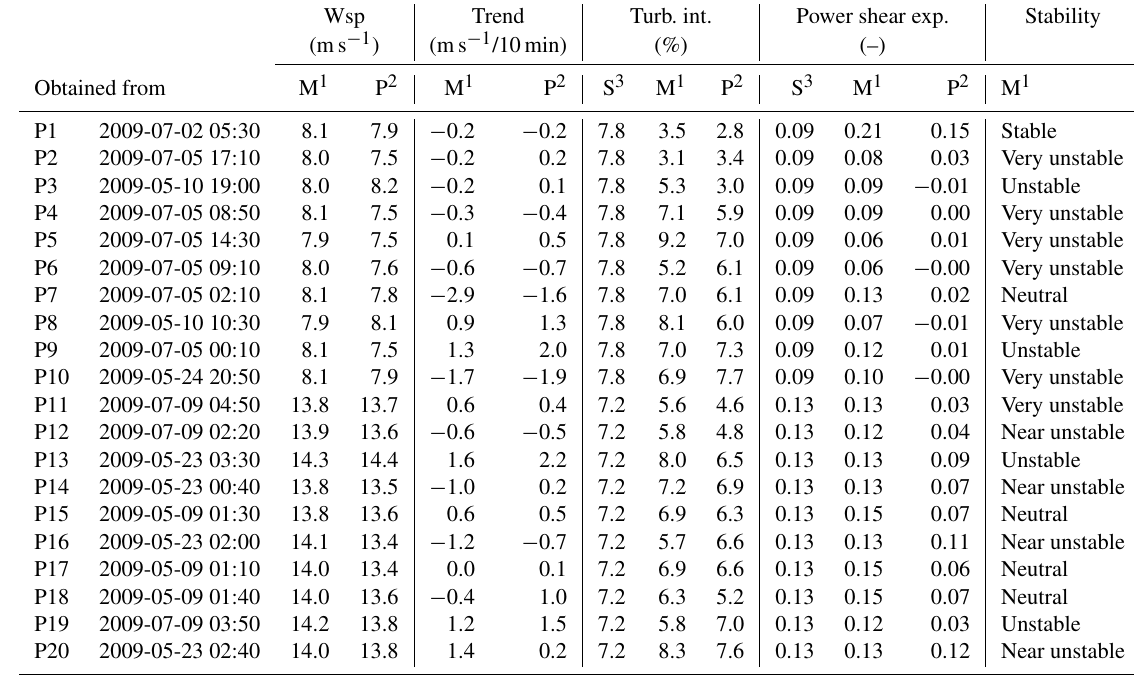
Table 2. Inflow characteristics of P1–P20 showing the wind speed (Wsp), wind speed trend (Trend), turbulence intensity (Turb. int.) and power shear exponent (Power shear exp). Wsp Trend Turb. int. Power shear exp. Stability